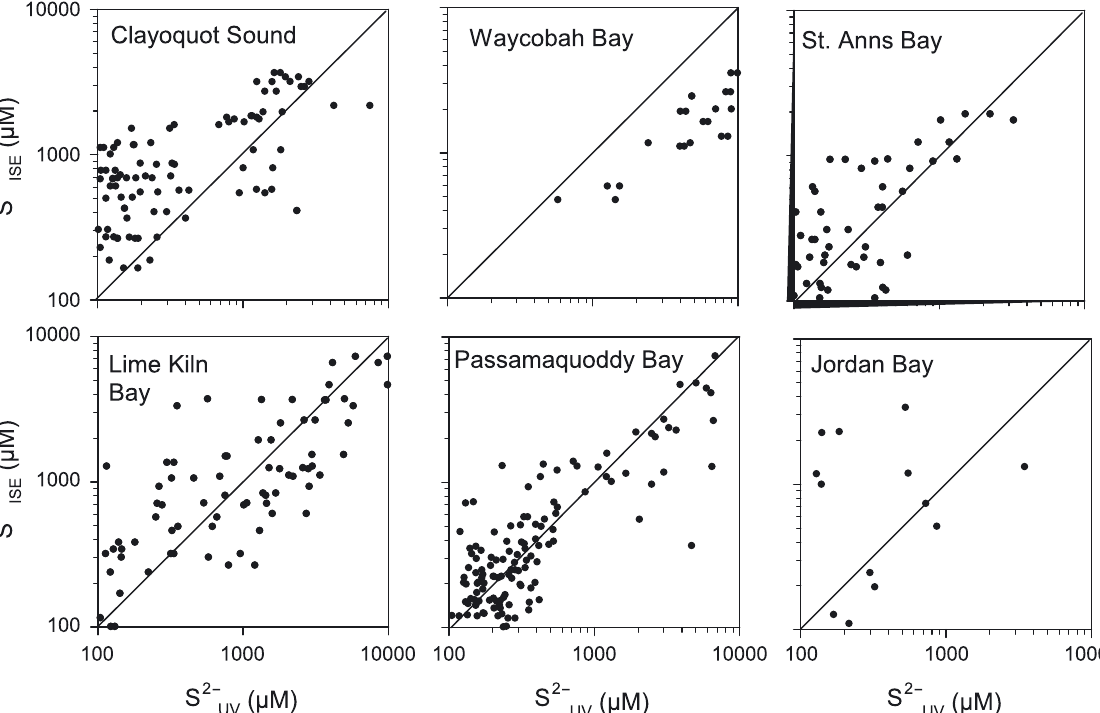
Fig. 8. Relationships between sediment total free sulfide concentrations analysed by UV spectrophotometry (S 2− UV ; mean for 1 and 2 cm depth samples) and ion-selective electrode (S 2− ISE , 0 to 2 cm depth samples) methods for multiple aquaculture locations (Tables 1 & 2). The unity line (1:1 relationship) is shown in each plot